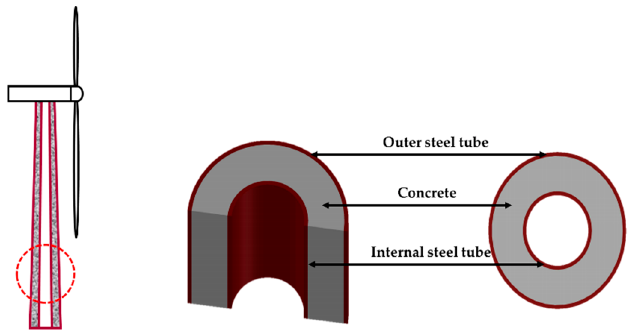
Figure 1. Cross section of DSCT wind turbine tower.